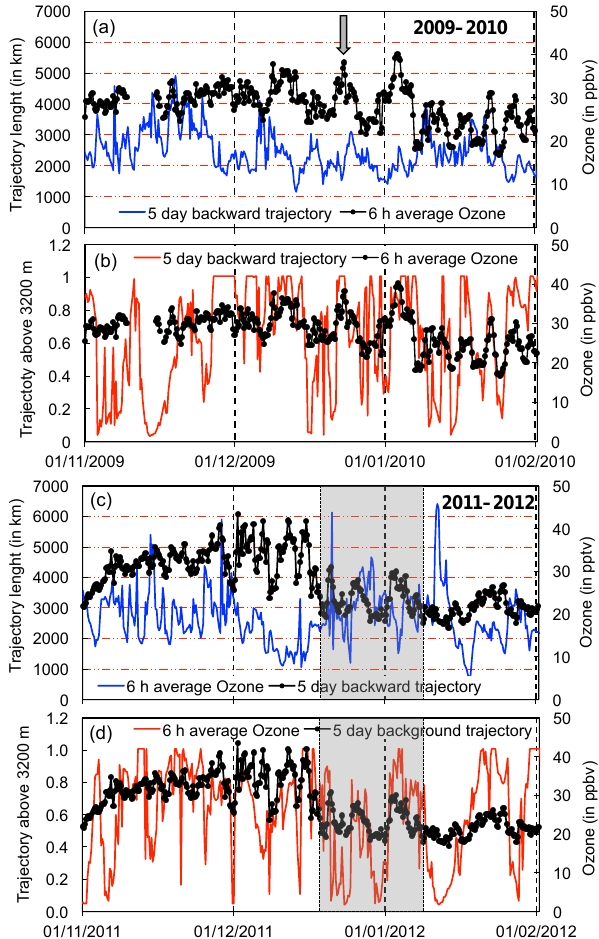
Figure 5. The 6h averaged ozone mixing ratio (black dots) and the corresponding 5-day backward trajectory at Concordia from the austral spring 2009 to fall 2010 (a, b) and from spring 2011 to fall 2012 (c, d) (arrival at 0ma.g.l.). The blue line is the trajec- tory length, the red line the fraction of the trajectory being above 3200m elevation. The grey arrow (a) refers to the day 23 Decem- ber during which the observed fast increase of ozone is discussed in Sect. 3.1.1. The grey area (c, d) denotes the sampling time period of the OPALE